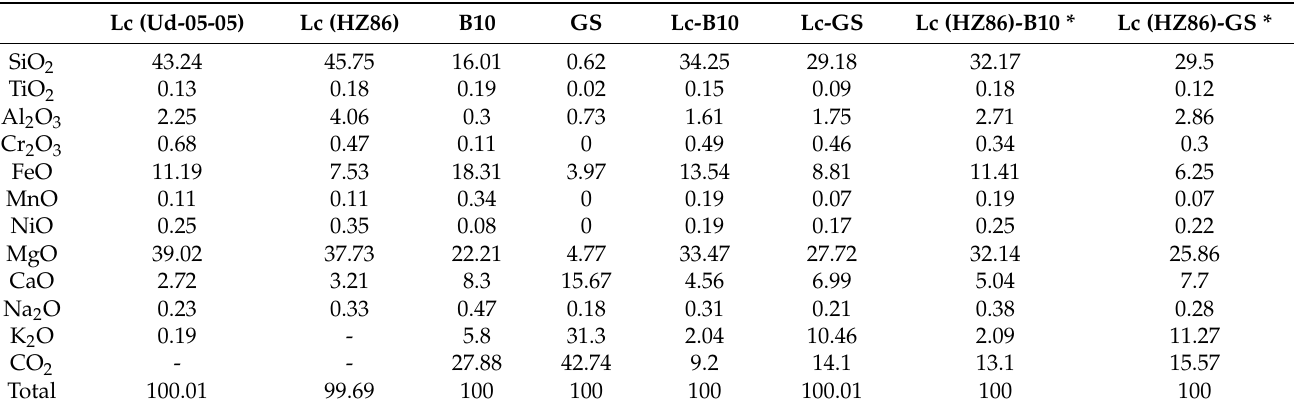
Table 1. Compositions of lherzolites from xenolith UD-05-05 (Lc), synthetic composition HZ86 (Lc), model carbonatitic melts (GS, B10) and bulk compositions of experimental